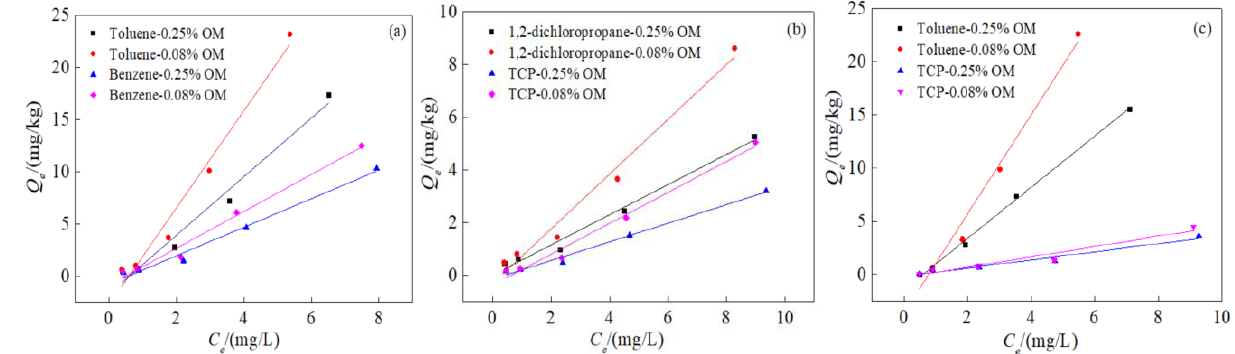
Figure 7. The effect of NOM on the competitive adsorption of ( a ) benzene and toluene, ( b ) TCP and 1,2 − dichloropropane, and ( c ) toluene and TCP in different two − component systems. (The content of soil organic matter before and after treatment was 0.25% and 0.08%,